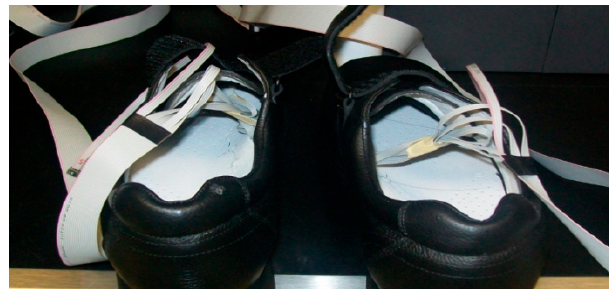
Figure 7. Array of ten sensors placed on flexible cables in the footwear.